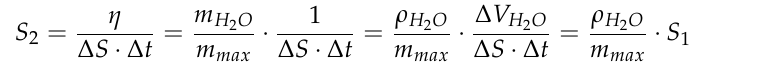
Figure 5. Dependence of the day-averaged water consumption of field-grown potatoes on time (according to data from [29]).